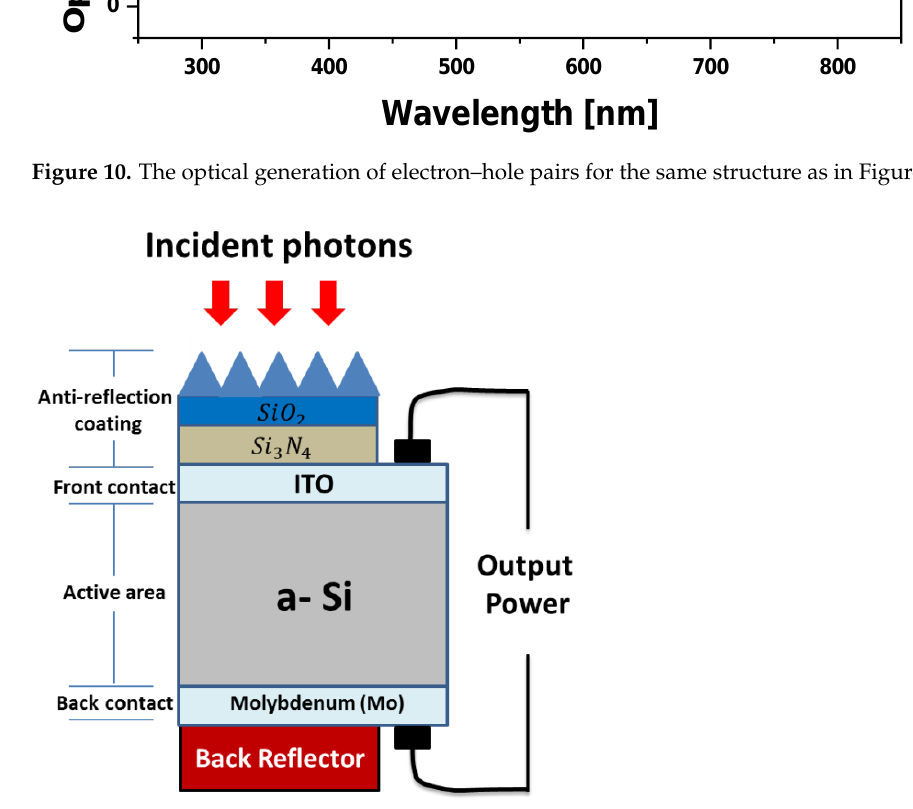
Figure 12. The refractive index and extinction coefficient of indium – tin – oxide (ITO) as a function of the incident wavelengths. Here, in Figure 13 we study the optical properties of the considered structure in Figure 11 and compare them with the optical properties of the cell as in Figure 9 in the case of normal incidence. By adding the two electrodes, the absorption of the cell is increasing at the smaller wavelengths, and this adding causes a small difference between the optical properties with and without the two electrodes, as we show in Figure 13. Thus, our structure is compatible with the experimental date. At the same time, the ITO layer is acting as a grading index and a front electrode for the cell. Therefore, our modified structure of the textured ARC is an optimum energy-harvesting solar cell. 300